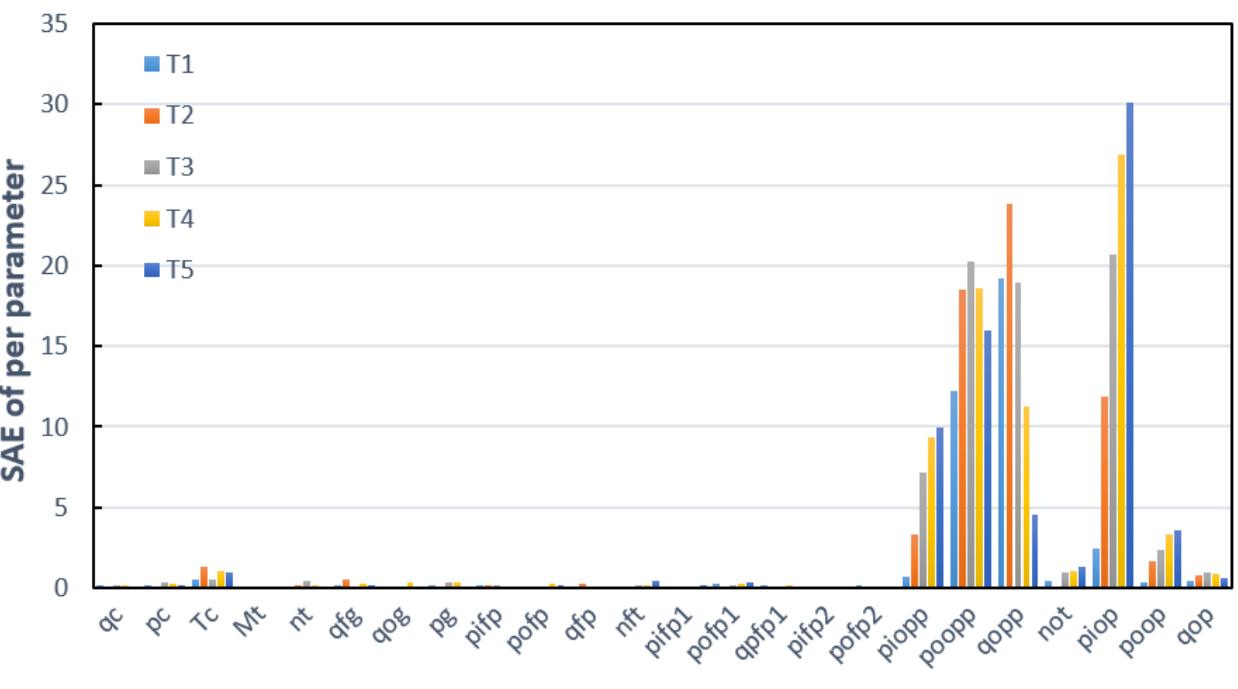
Figure 11. SAE of five consecutive samples after injection fault of test 14.